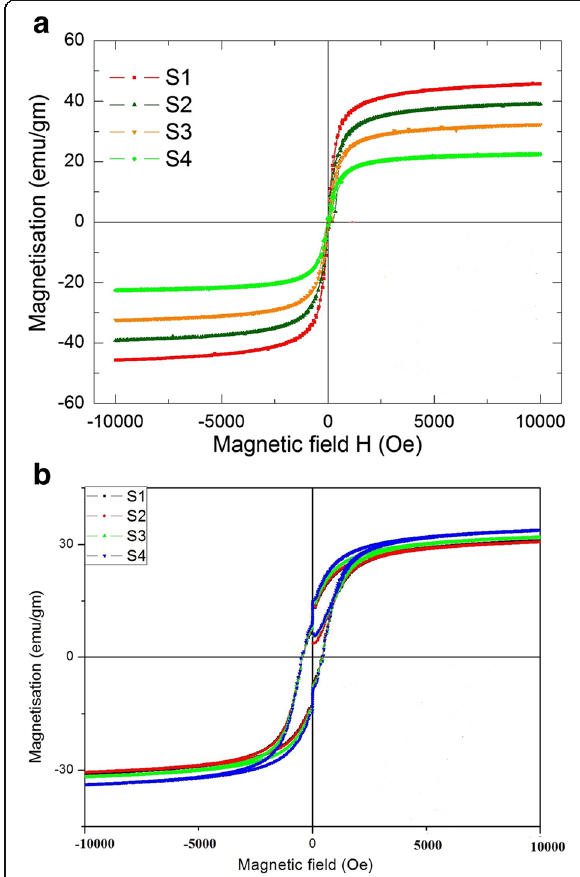
Fig. 3 a Magnetization vs. magnetic field plot of different Fe 3 O 4 samples at 300 K. b Magnetization vs. magnetic field plot of different Fe 3 O 4 samples at 5 K